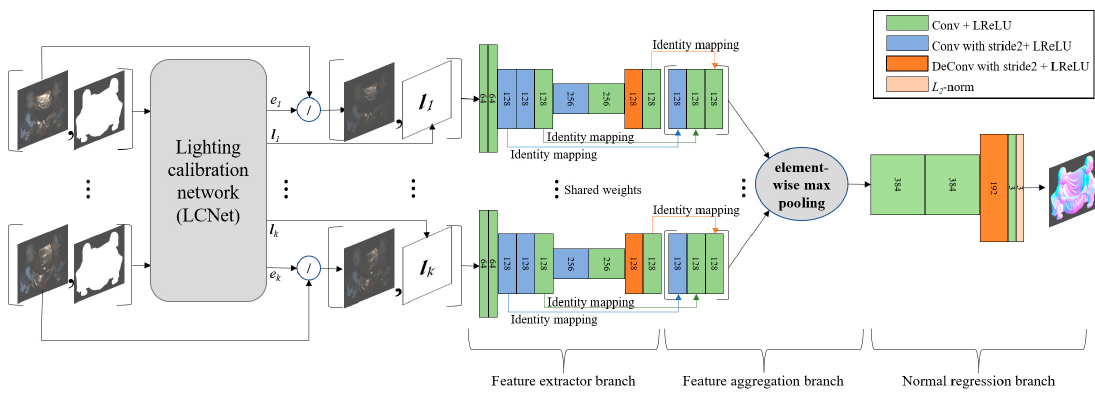
Figure 2. Network architecture for uncalibrated photometric stereo. The numbers in layers depict the number of output channels.